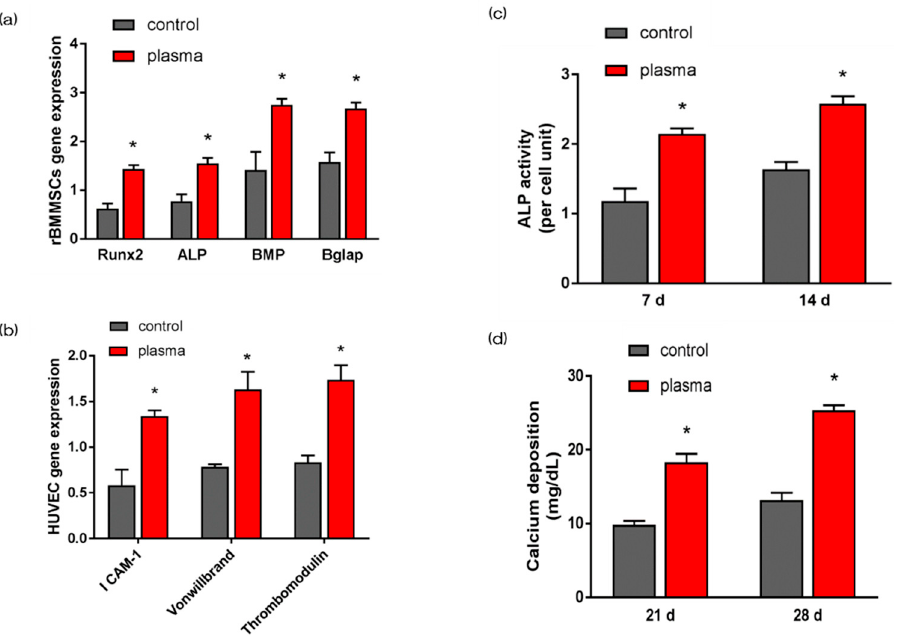
Figure 4. Quantitative real-time (qRT)-PCR analysis of osteogenesis and angiogenesis related gene expression in control and test groups ( a , b ). ALP activity in control and test groups ( c ). Ca deposition in control and test groups ( d ). * p < 0.05.